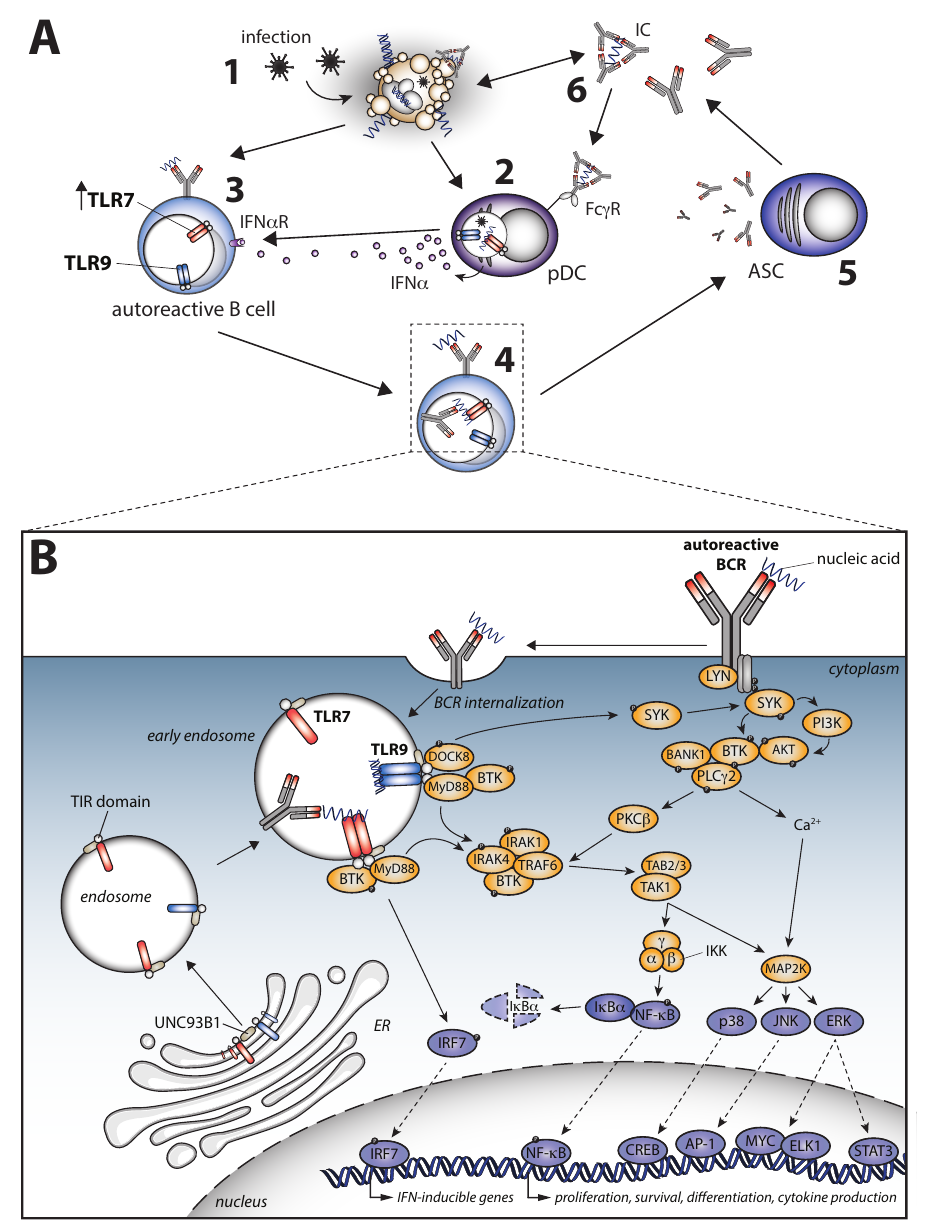
Figure 3. The vicious cycle of autoreactive B cell activation and the interplay between BCR and TLR signaling. ( A ) 1, A viral infection induces inflammation and cellular apoptosis and necrosis. This can lead to the accumulation of debris, containing autoantigens and nucleic acids. 2, Plasmacytoid dendritic cells (pDCs) are activated during viral infections via Toll-like receptors (TLR) and produce vast amounts of interferon- α (IFN- α ). 3, IFN- α stimulates autoreactive B cells via the IRF α receptor, causing upregulation of TLR7 expression. Meanwhile, the B cell is activated via the B cell receptor (BCR) by self-antigen and internalizes the antigen. 4, The autophagosome, containing self-antigen bound to the BCR, and the endosome, containing TLRs, fuse. Self-antigens, containing TLR ligands, stimulate both BCR and TLR in a synergistic manner. 5, Autoreactive B cells proliferate and differ- entiate into antibody-secreting cells (ASC). These produce high numbers of autoreactive antibodies. 6, Autoreactive antibodies recognizing self-antigen form immune complexes (IC). In turn, these can promote inflammation at the site of deposition and stimulate pDCs via fragment crystallizable region γ receptor (Fc γ R) to increase IFN- α production, completing the cycle. ( B ) Synergy of BCR and TLR signaling pathways leading to the activation of autoreactive B cells. Signaling molecule abbreviations are explained in the